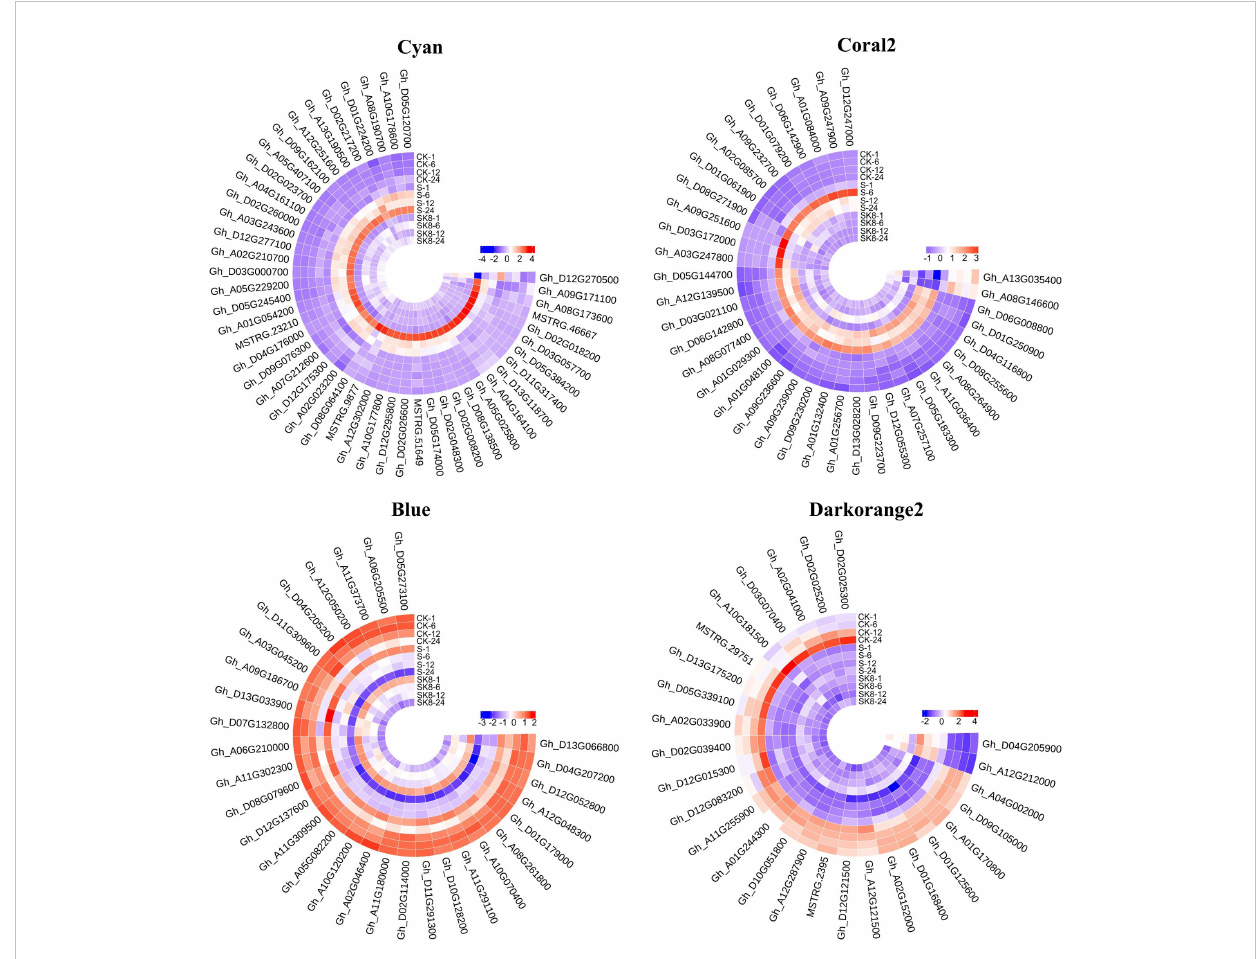
FIGURE 6 Heatmap of hub genes and their associated gene expression patterns in key modules. The color in the heatmap indicates the gene expression. Red represents high expression, and blue represents low